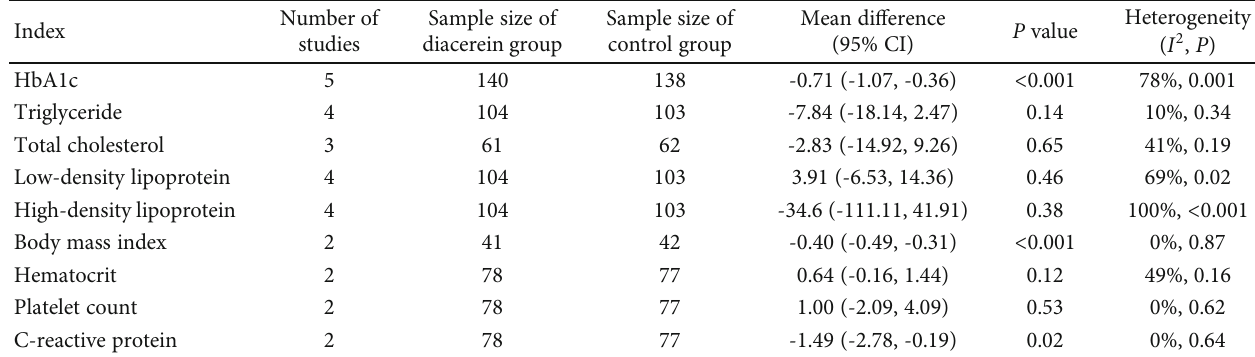
Table 2: Di ff erence in secondary outcomes between the diacerein group and control group.